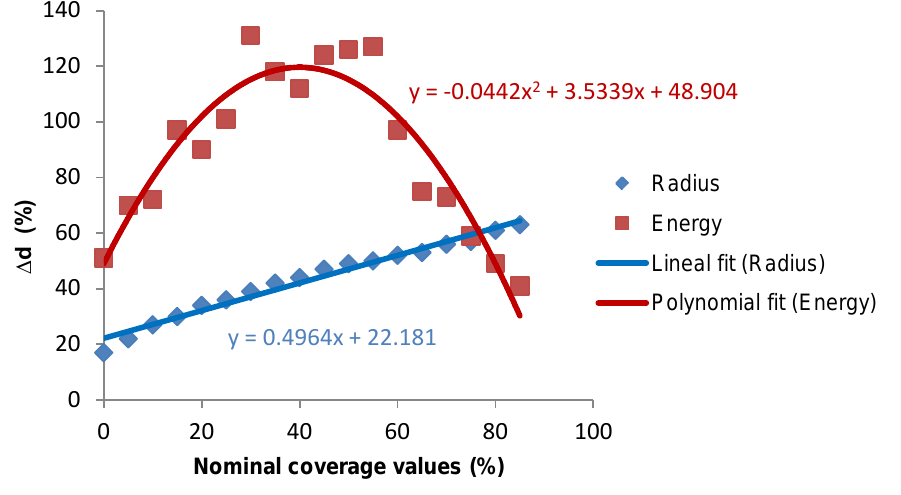
y = 0.4964x + 22.181